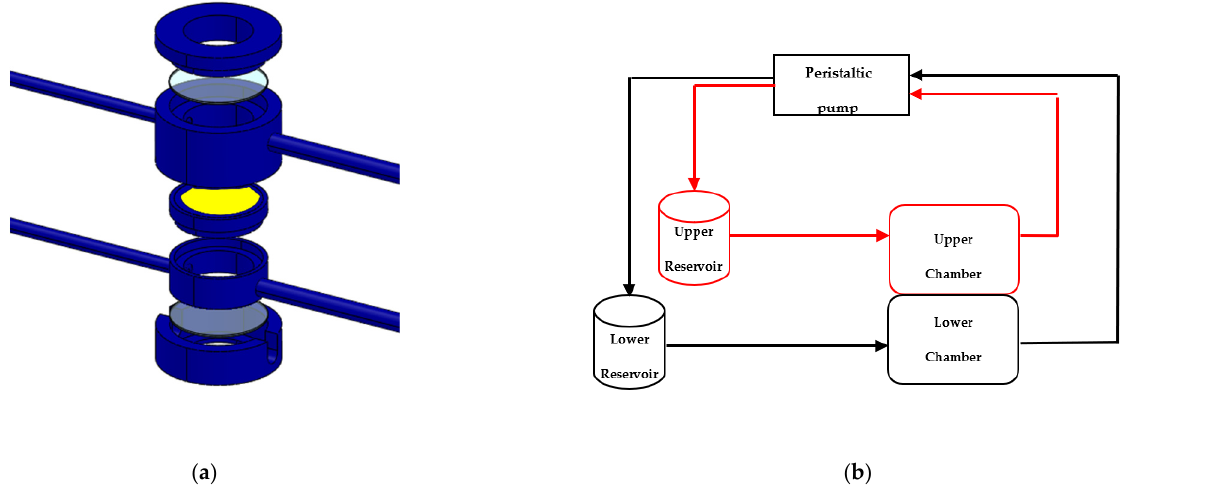
Figure 1. The 3D schematic exploded view of Livebox2 dynamic bioreactor composed by an upper chamber and a lower chamber separated by a porous membrane (yellow) with an appropriate rounded microscopy coverslip ( a ). Chambers of the bioreactor are connected to their respective reservoirs and to a peristaltic pump ( b ).